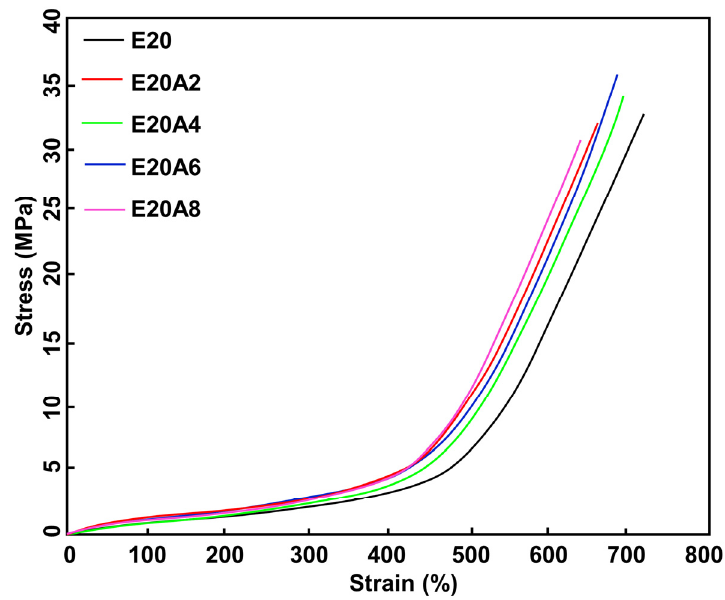
Figure 10. Stress-strain relationships of ENR/HNT composites filled with untreated and acid-treated HNT. Table 3. Modulus at 100% (M100), 300% (M300), tensile strength (TS), elongation at break (EB), tear strength (Ts), and hardness of ENR/HNT composites filled with untreated and acid-treated HNT.